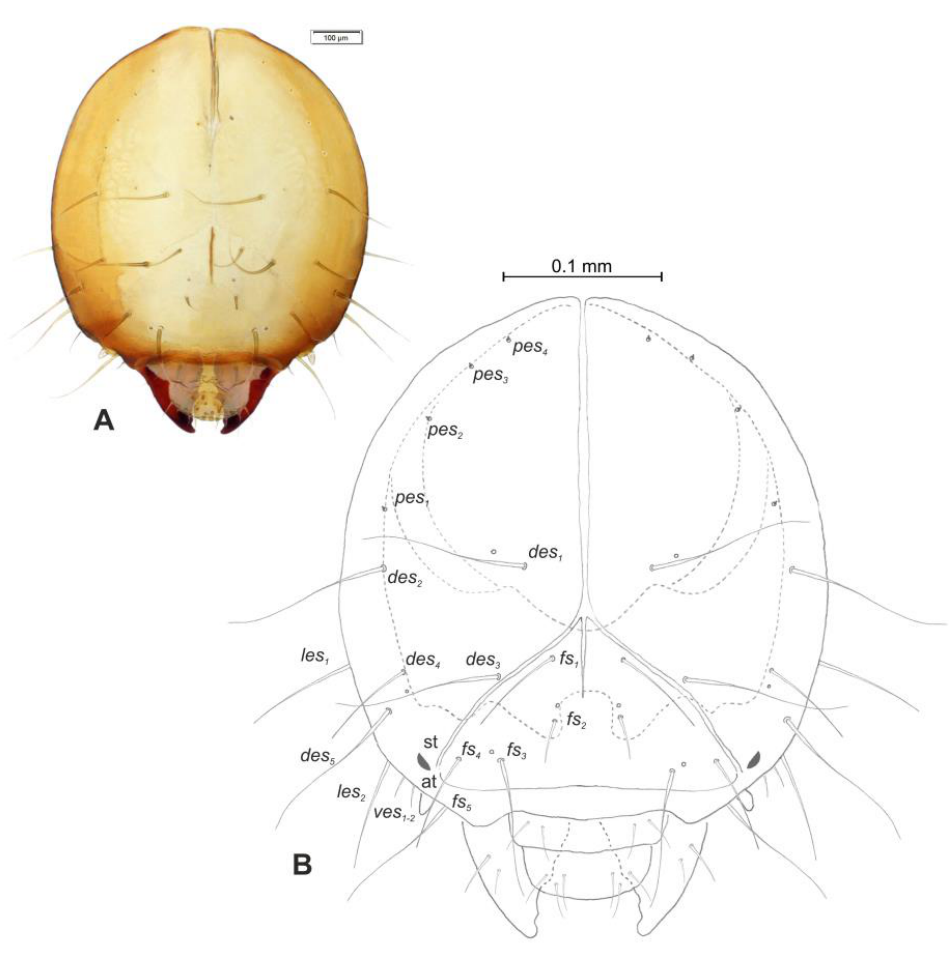
Figure 6. Euryommatus mariae mature larva, head, frontal view. ( A ) Frontal view, photo; ( B ) frontal view, scheme (at—antenna, st—stemmata, setae: des —dorsal epicranial, fs —frontal, ls —lateral epicranial, pes —postepicranial).